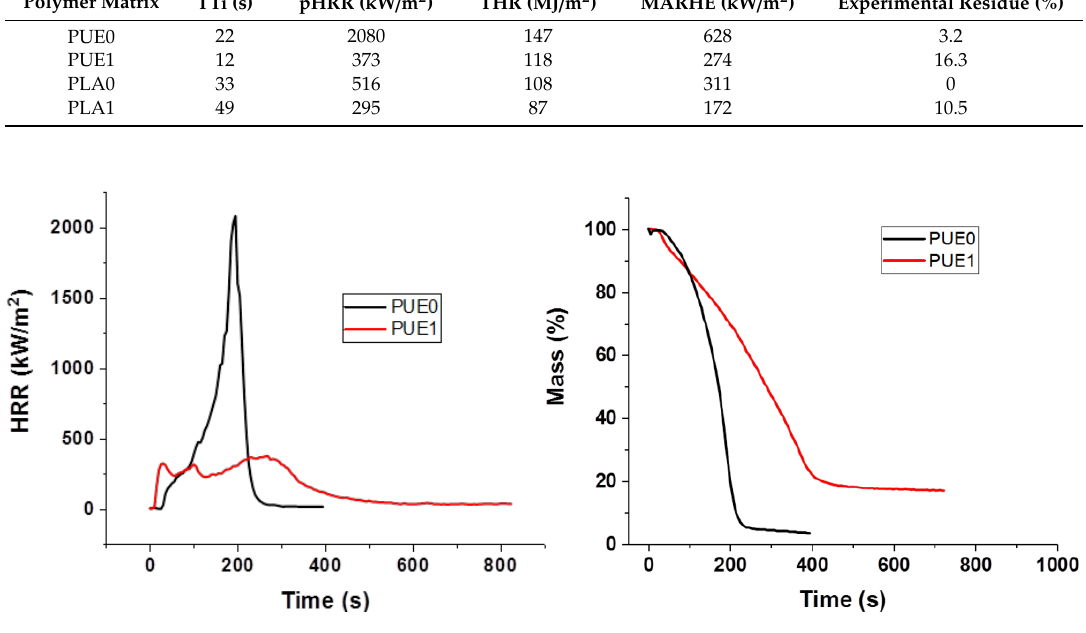
Figure 4. Heat release rate and mass for PUE/APP composites from cone calorimeter.